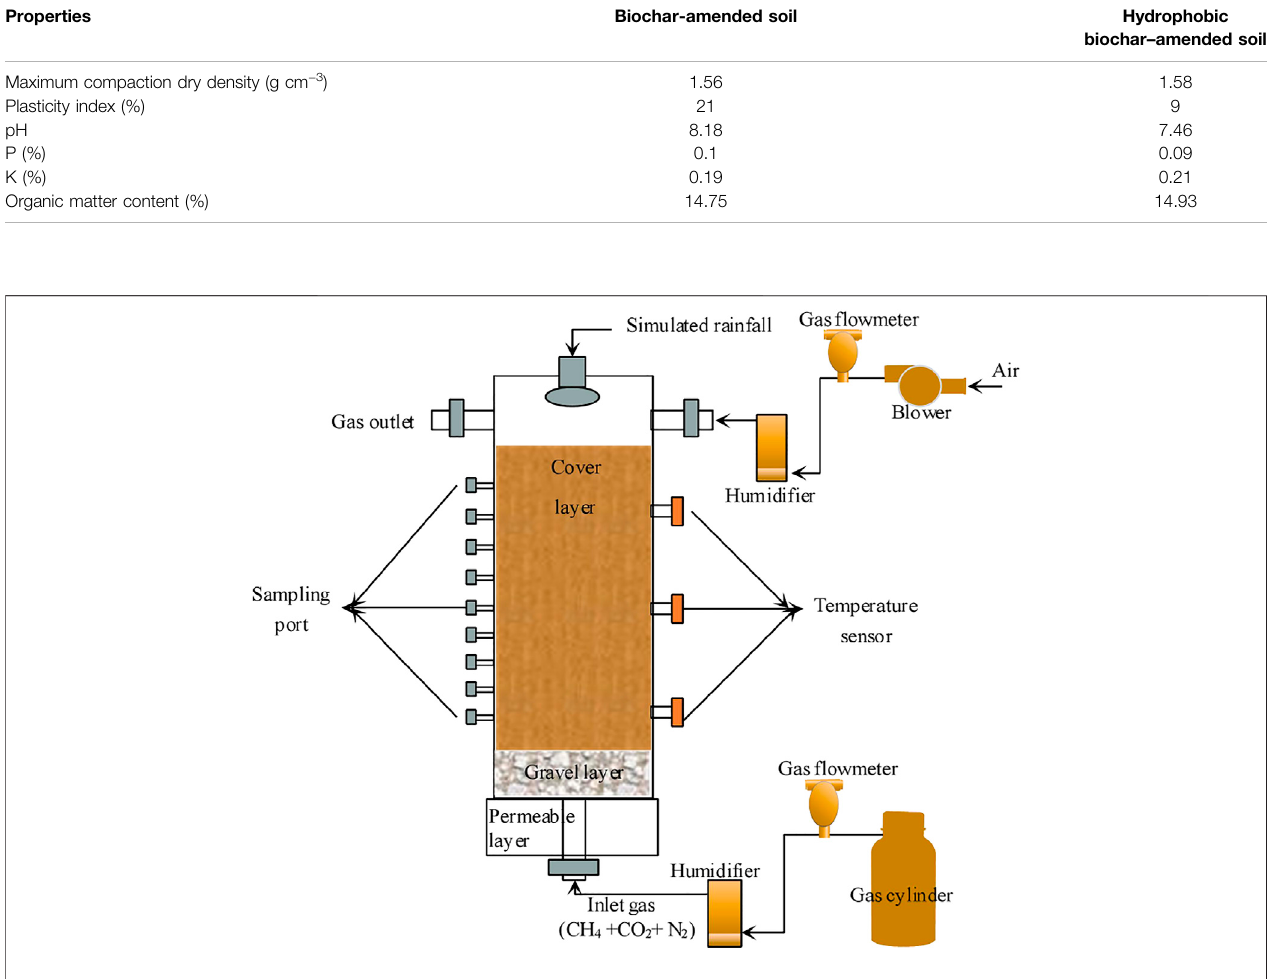
FIGURE 1 | Schematic of the land fi ll cover – simulated